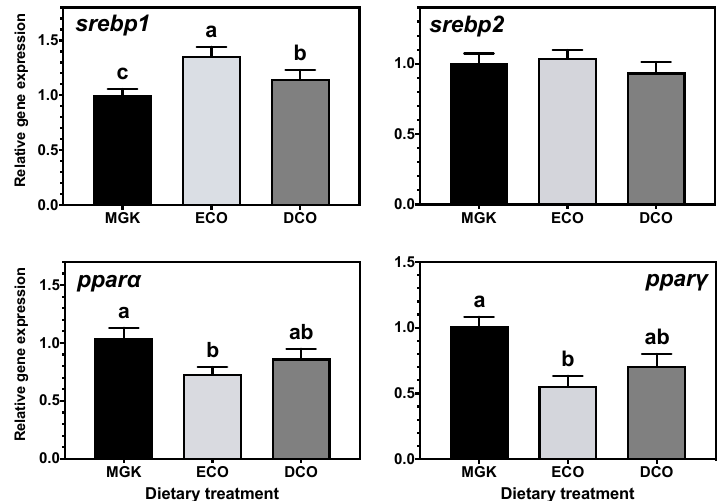
Figure 6. Nutritional regulation of sterol regulatory element-binding protein 1 and 2 ( srebp1 and srebp2 respectively), peroxisome proliferator-activated receptor alpha ( ppar α ) and gamma ( ppar γ ) gene transcription in intestine of Atlantic bluefin tuna ( Thunnus thynnus L.) juveniles fed a reference diet Magokoro ® (MGK) and two test diets containing either EPA (ECO) or EPA + DHA (DCO) oils from transgenic Camelina sativa seeds. Values are normalised expression ratios to MGK reference diet and are means ± SD ( n = 6). Values with different superscript letters are significantly different (one-way ANOVA and Tukey test; p < 0.05).